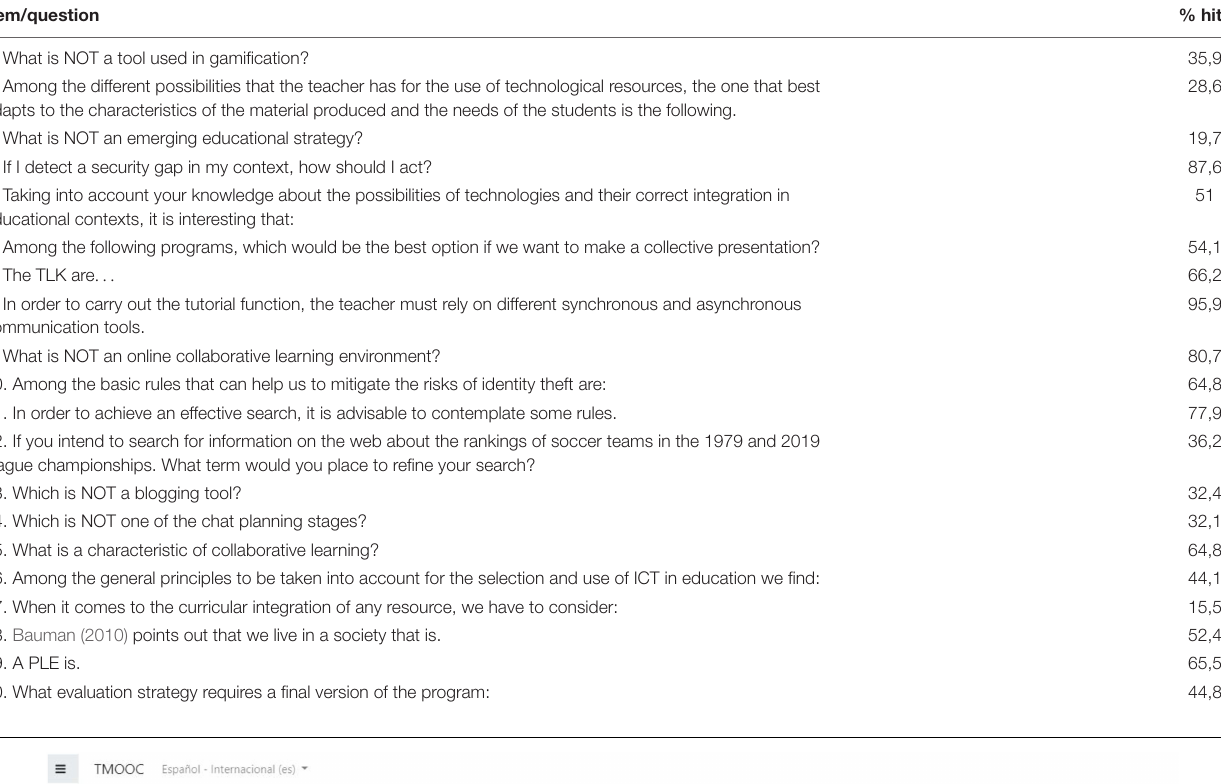
TABLE 6 | Test results content (% hits).